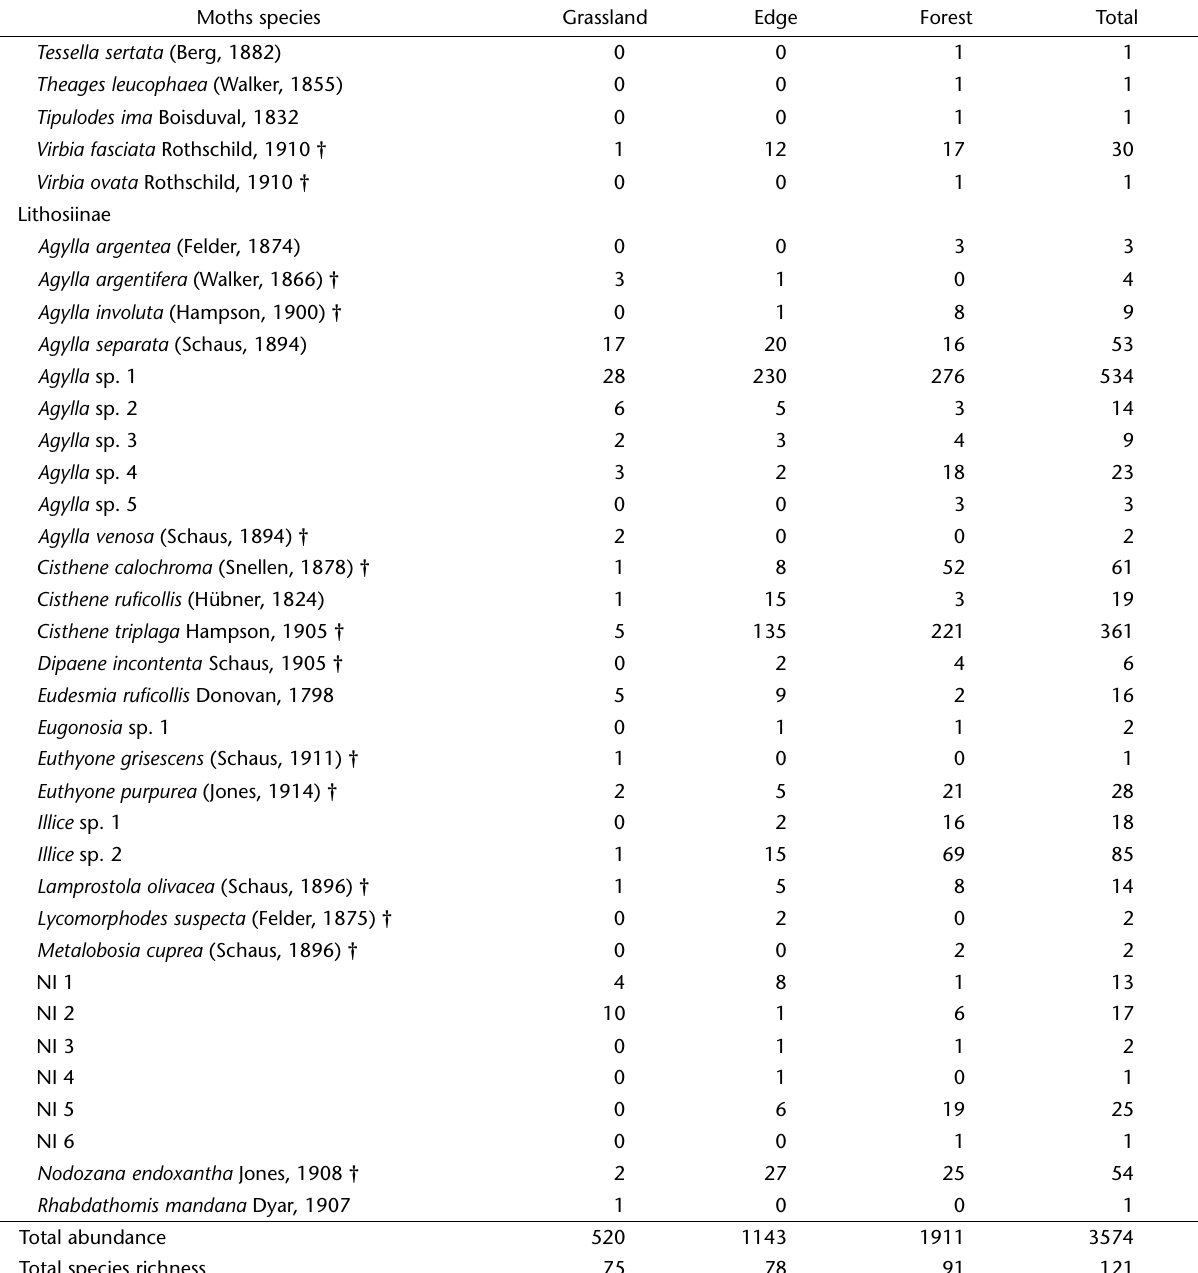
the grassland sites was lower than among the edge/forest